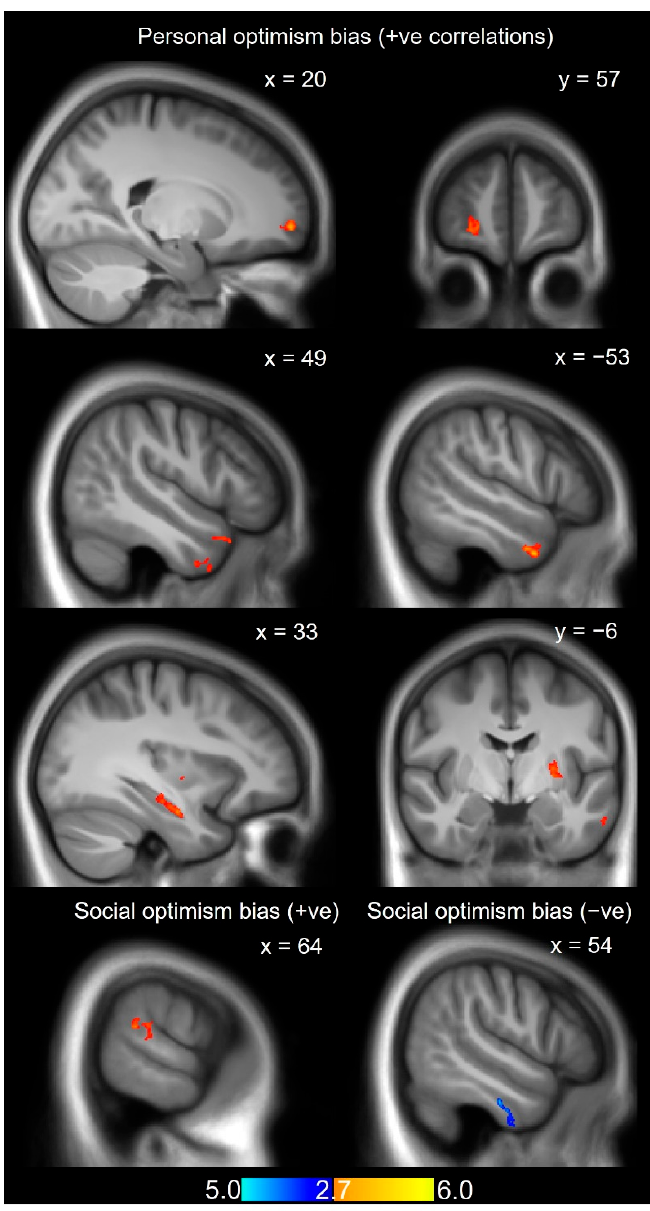
Figure 3. VBM findings for personal optimism bias and social optimism bias. Personal bias: A positive correlation between GMV and personal optimism bias arose in areas including the right frontal pole ((x = 20, sagittal) and (y = 57, coronal)), right temporal pole (x = 49, sagittal), left temporal pole (x = − 53, sagittal), left hippocampus (x = − 33, sagittal), and left putamen (y = − 6, sagittal). Social bias: A positive correlation was observed between GMV and social bias in the right temporoparietal junction (x = 64, sagittal) and a negative correlation in right inferior temporal gyrus (x = 54, sagittal). All findings are overlaid on an average template created by normalized anatomical scans across participants. ‘+ve’ stands for positive correlations between GMV and optimism bias (personal/social), and ‘-ve’ stands for negative correlations between GMV and social optimism